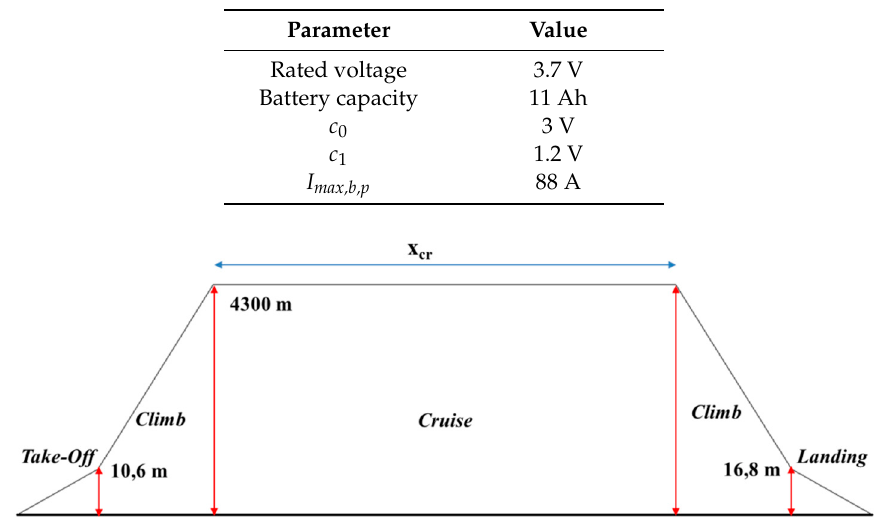
Table 2. Main parameters of the considered lithium battery pack.